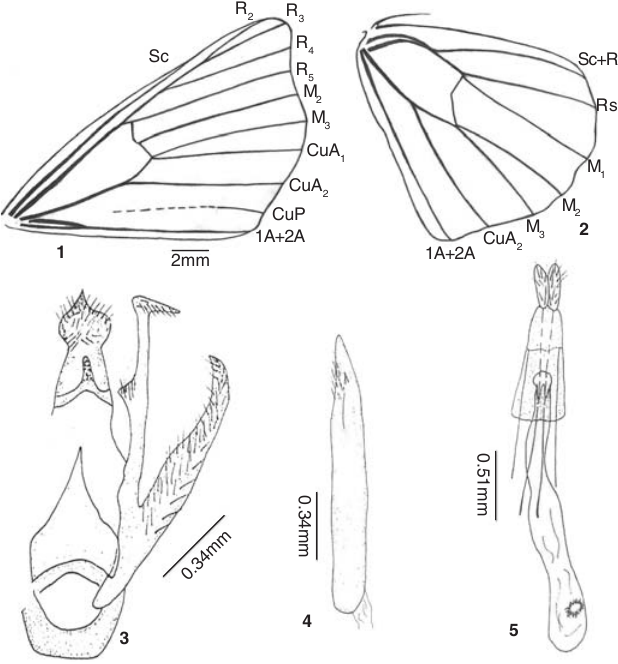
Figures 1-5. Zamarada pseudobaliata sp. nov. 1 - Forewing venation; 2 - Hindwing venation; 3 - Male genitalia ventral view; 4 - Aedeagus; 5 - Female genitalia ventral